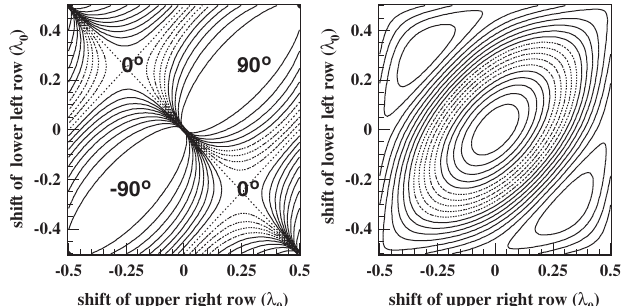
FIG. 2. Parameter space of an APPLE undulator: phase be- tween transverse magnet field components (left) and effective =B varies between infinity at fields (right). The field ratio B y; 0 x; 0 s 1 ¼ s 2 ¼ 0 and zero at s 1 ¼ (cid:5) 0 : 5 and simultaneously s 2 ¼ (cid:5) 0 : 5 . The data are evaluated for a period length of 56 mm and a gap of 15 mm and they change slightly for other